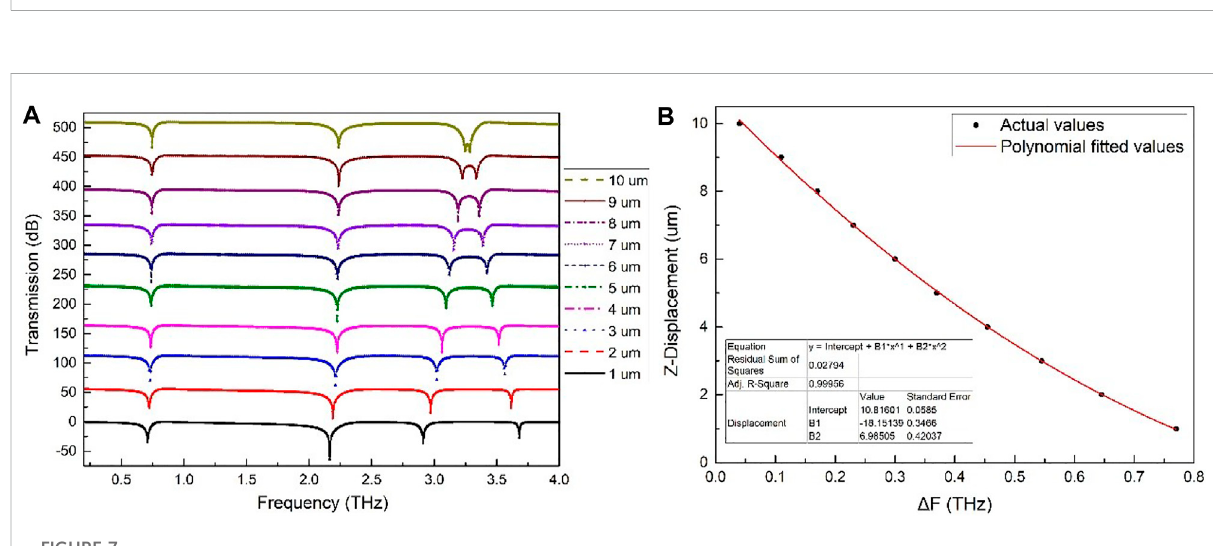
TABLE 1 The performance parameters of the terahertz (THz) displacement sensor. sensor are obtained: S is 125 GHz/ μ m, Q value is 148.5, and FOM is 6.25, as shown in Table 1.